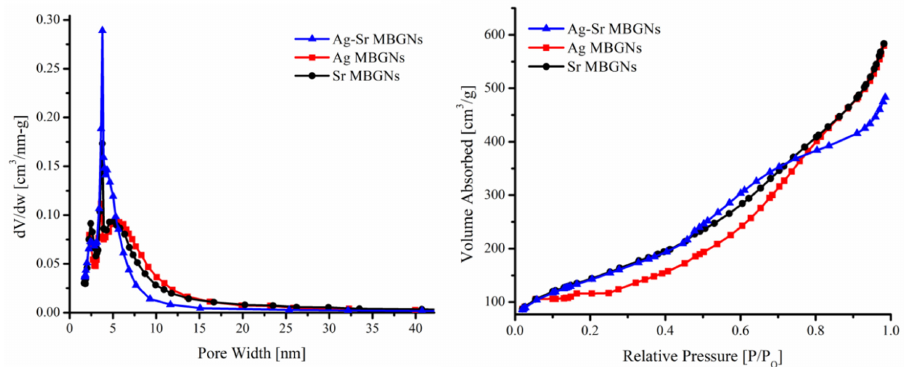
Figure 2. BET (Brunauer-Emmett-Teller) results showing the pore size distribution ( left ) and nitrogen adsorption- desorption isotherms of synthesized bioactive glass nanoparticles ( right ).